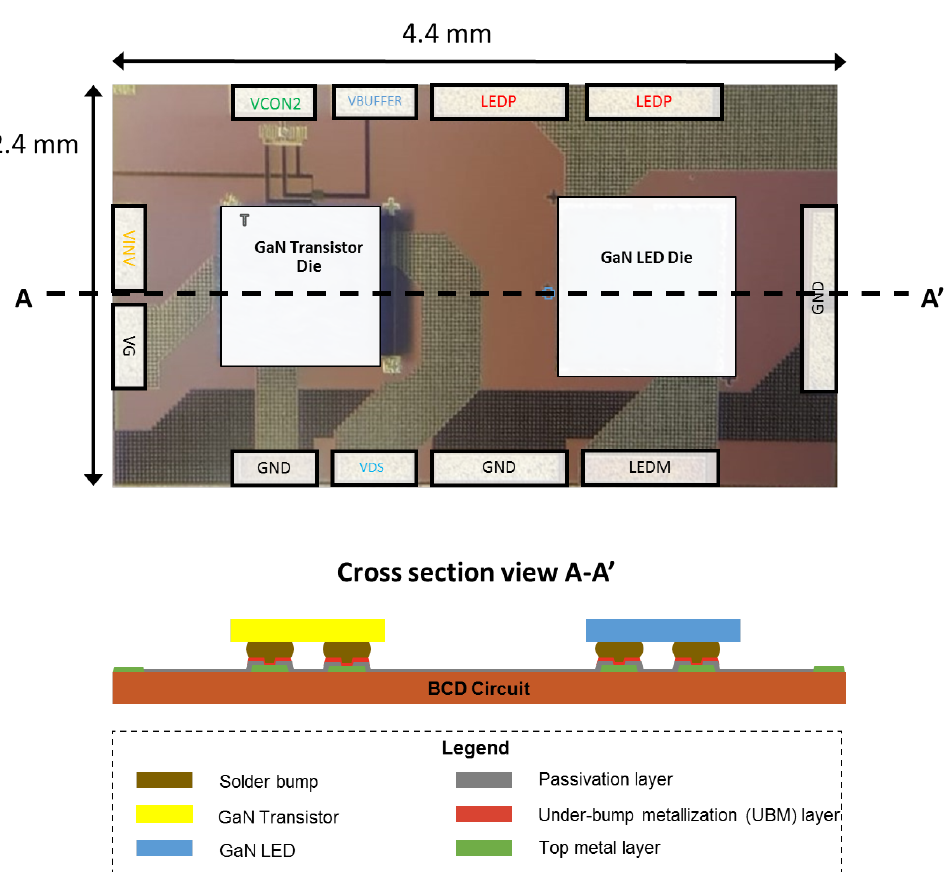
Figure 8. Photograph indicating bond pad layouts for bonding of GaN elements atop LED driver IC with the cross-section sketch view depicting the GaN 2 BCD TM technology.